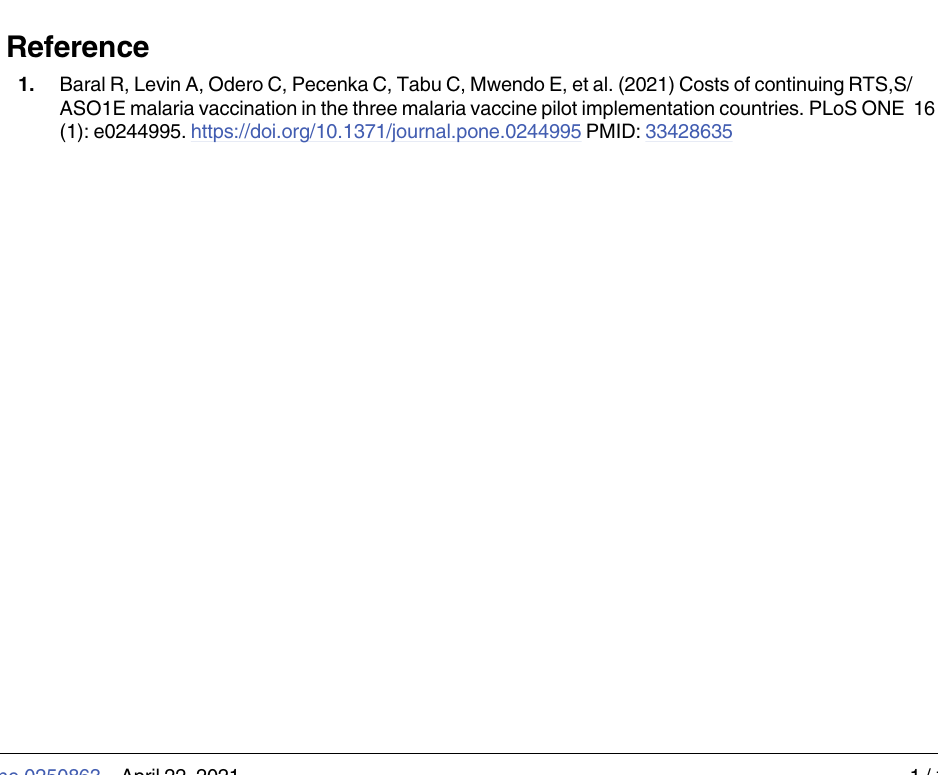
S4 Table. Unit cost of continuing to vaccinate in pilot areas at various vaccine